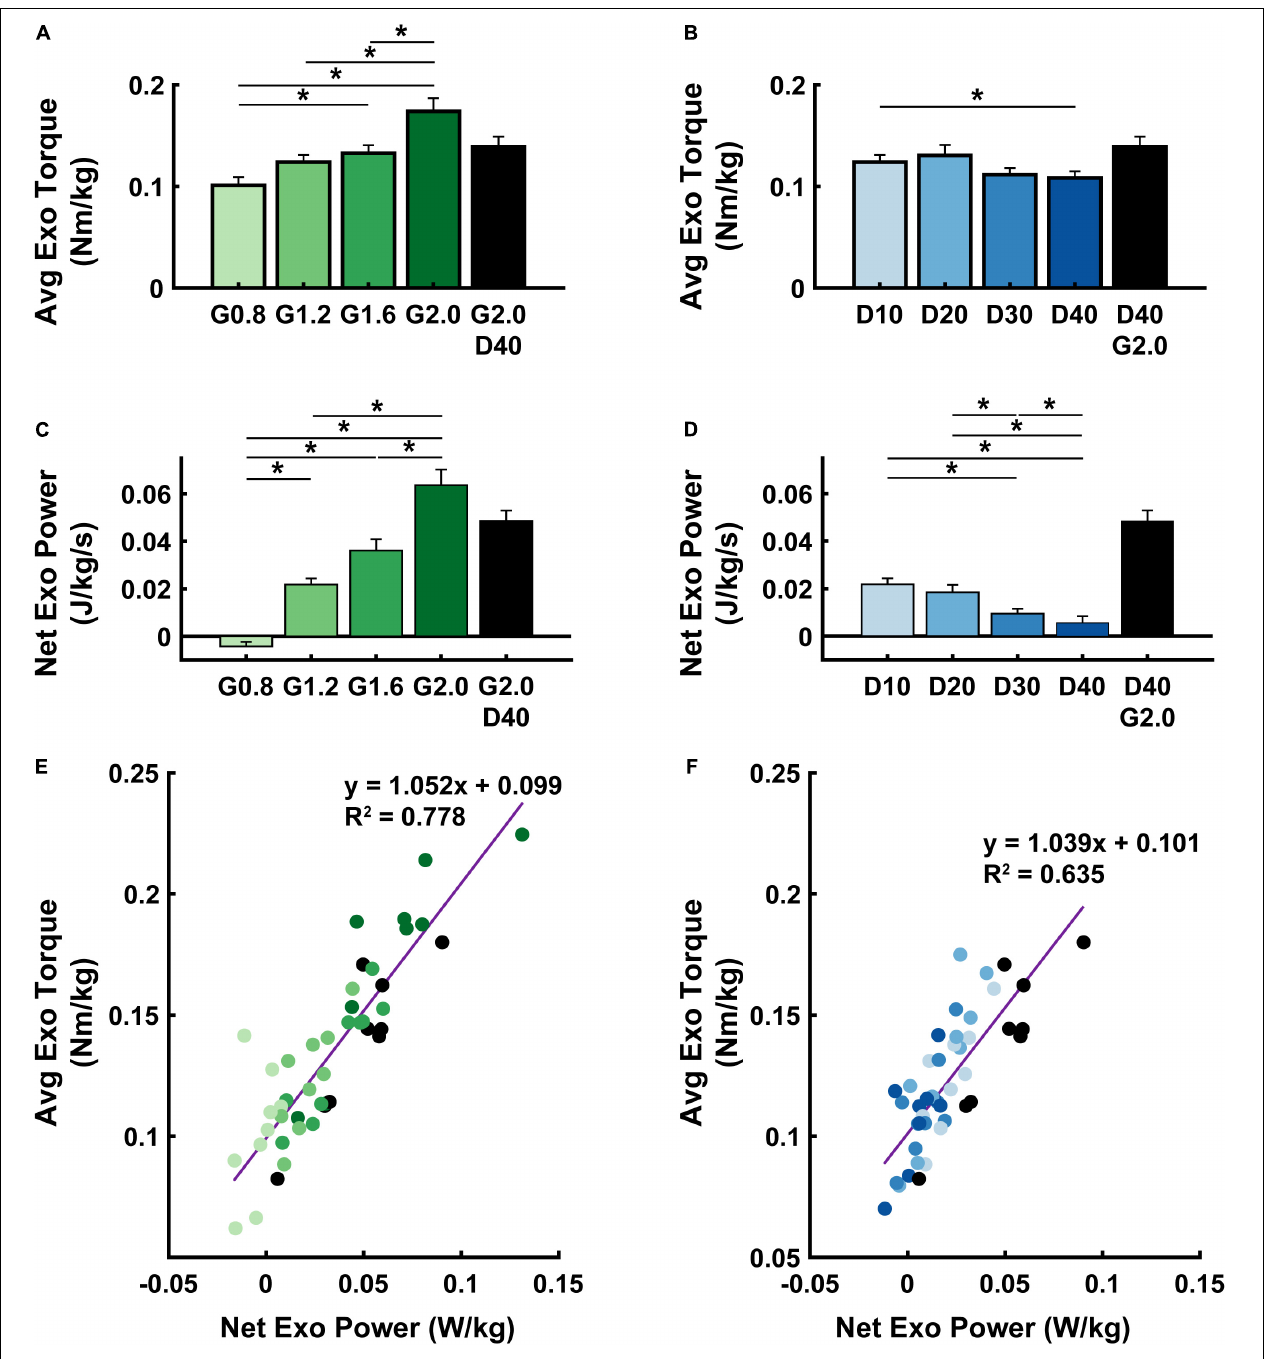
FIGURE 3 | Exoskeleton mechanics. Average ( ± S.E.M., N = 9 participants) exoskeleton torque (A,B) , net exoskeleton power (C,D) , and a linear regression between the two (E,F) across NMM controller reflex Gain (green) (A,C,E) and Delay (blue) (B,D,F) conditions. * denotes pairwise significant difference with p < 0.05. R 2 values are denoted with a “ ∼ ” if the linear regression was not statistically significant. Conditions are abbreviated and color coded as follows: NMM reflex Gains of 0.8, 1.2, 1.6, and 2.0 all with reflex Delay = 10 ms (G0.8, G1.2, G1.6, and G2.0, respectively) (green), NMM reflex Delays of 10, 20, 30, and 40 ms all with a reflex Gain = 1.2 (D10, D20, D30, D40, respectively) (blue), and a high-Gain-high-Delay condition (G2.0 D40) (black).